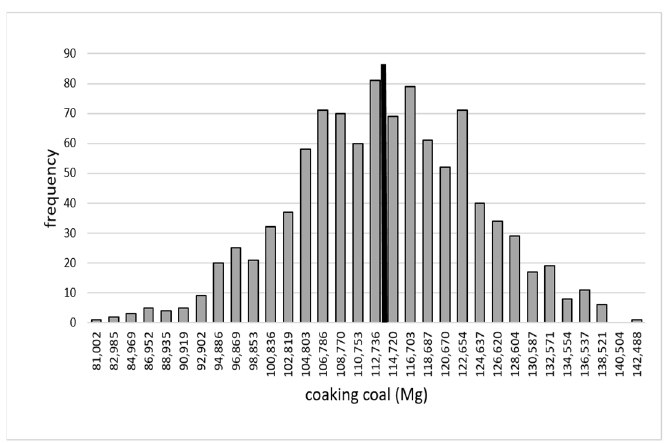
Figure A4. Histogram showing frequencies of achieving given quantity of sales of coking coal for mine “B” with σ yprog .